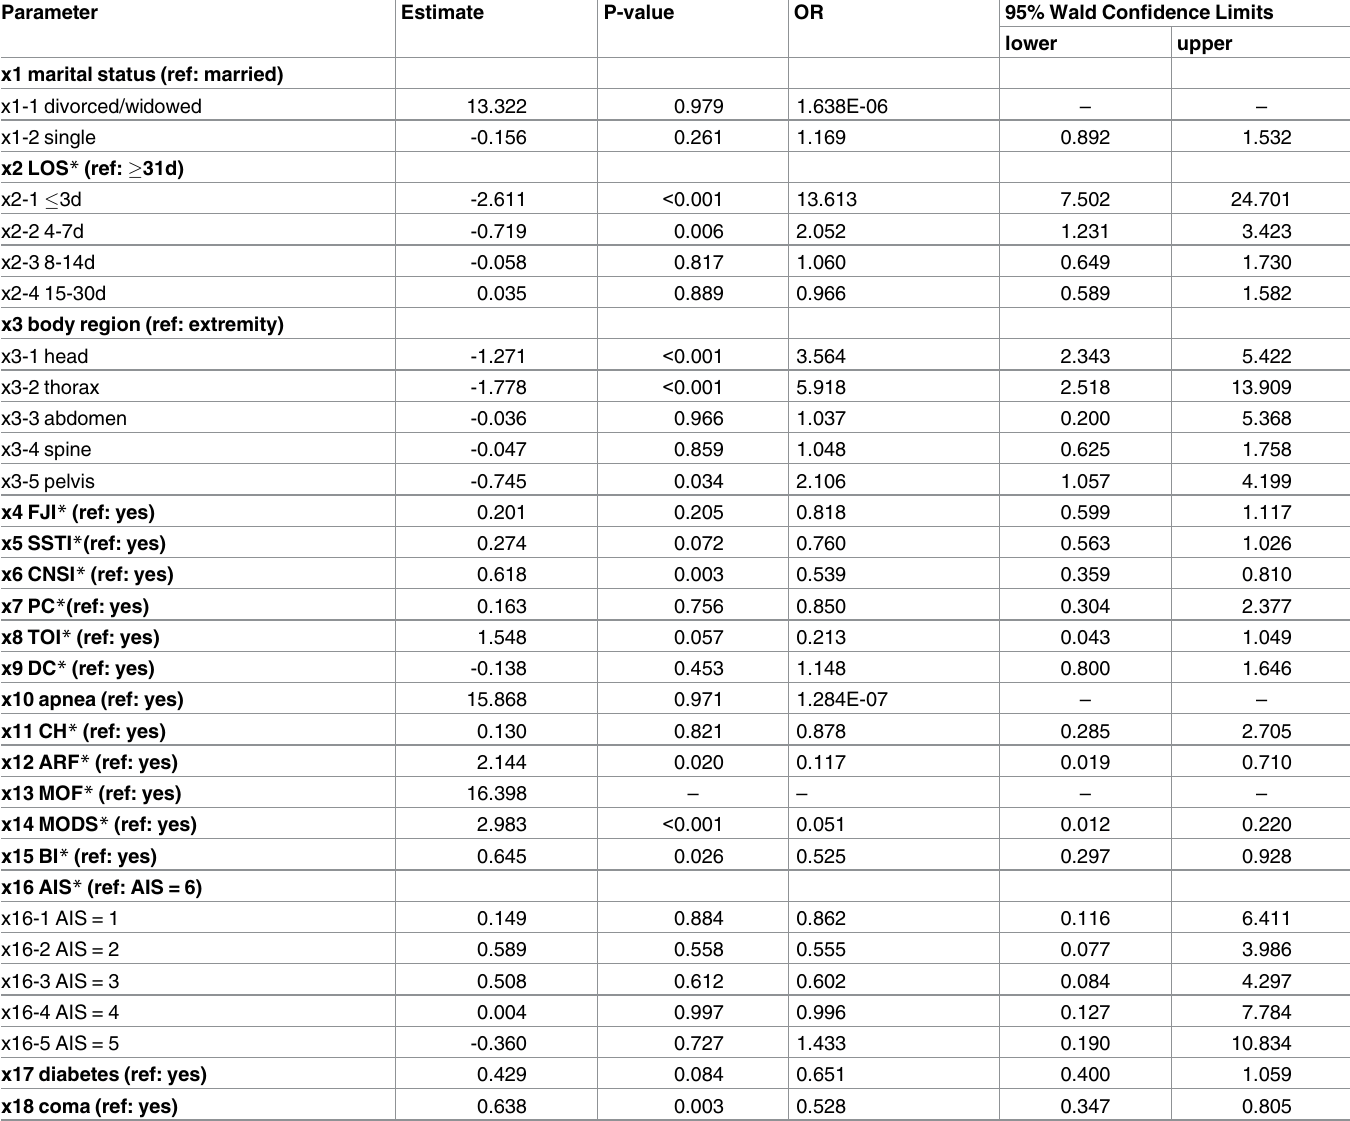
Table 3. Hierarchical logistic regression analysis for single-RTI